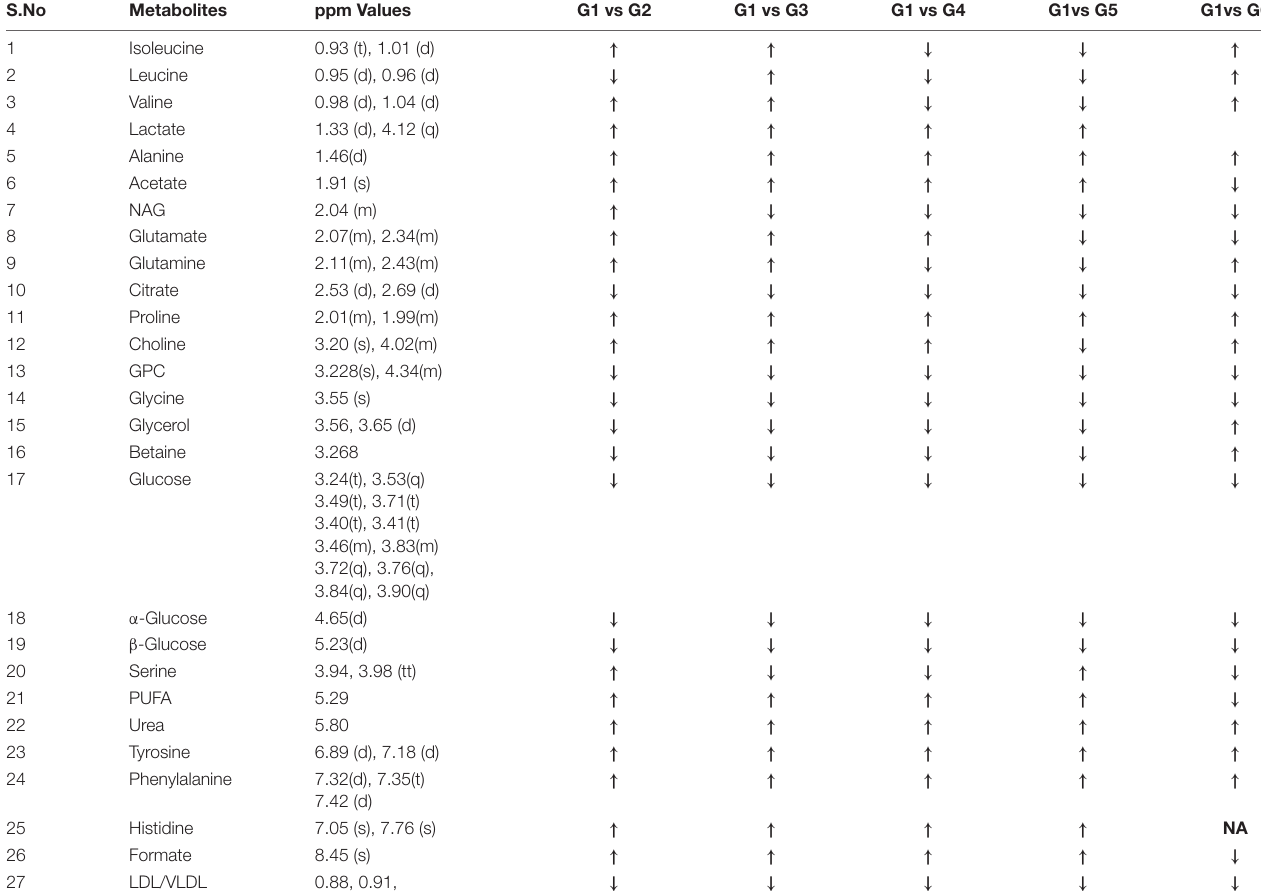
TABLE 3 | List of cross analyzed